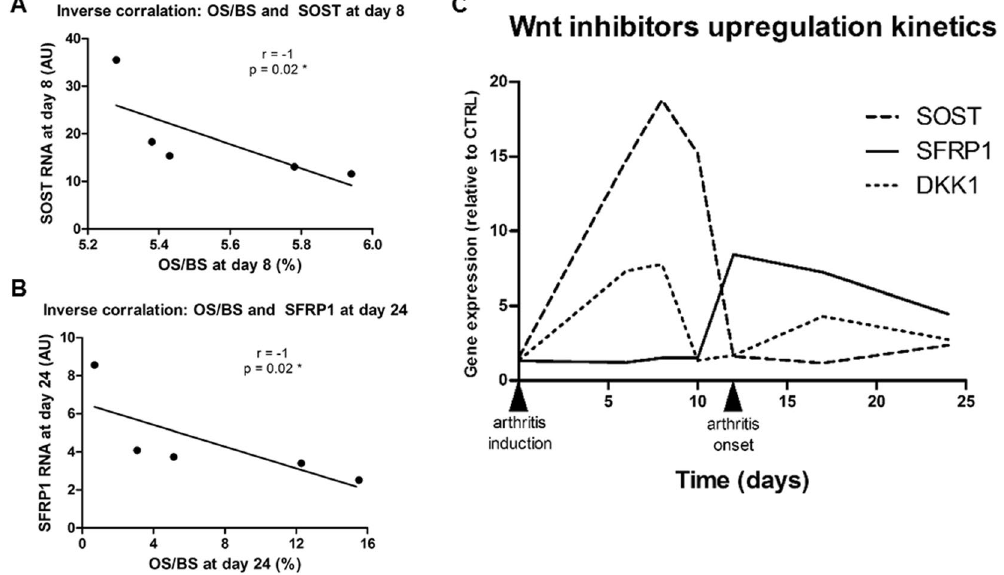
Figure 6. Loss of OS/BS correlated with SOST at day 8, but with SFRP1 at day 24. Spearman correlations were performed between OS/BS and ( A ) SOST at day 8 and ( B ) SFRP1 at day 24. ( C ) Relative expression of SOST, SFRP1, and DKK1 over time in AIA group compared to CTRL group. Bimodal kinetics with SOST and DKK1 highly expressed before arthritis onset followed by high SFRP1 expression only after arthritis onset. Furthermore, SOST peak relative expression to CTRL was dominant compared to DKK1 or SFRP1. OS/BS: osteoid surface/bone surface; AU: arbitrary units; DKK1: dickkopf 1; SFRP1: secreted frizzled related protein 1. Spearman correlations; r: Spearman coefficient, * p <